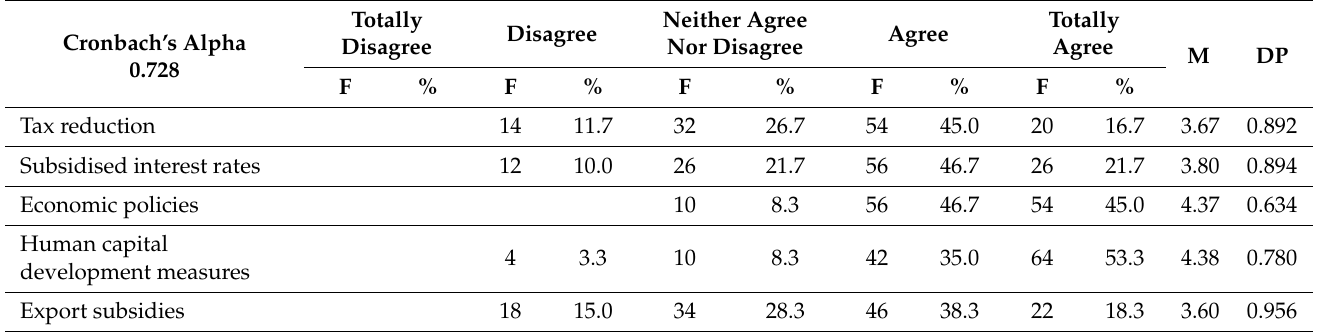
Table 10. Measures that the government should take to diversify the Angolan